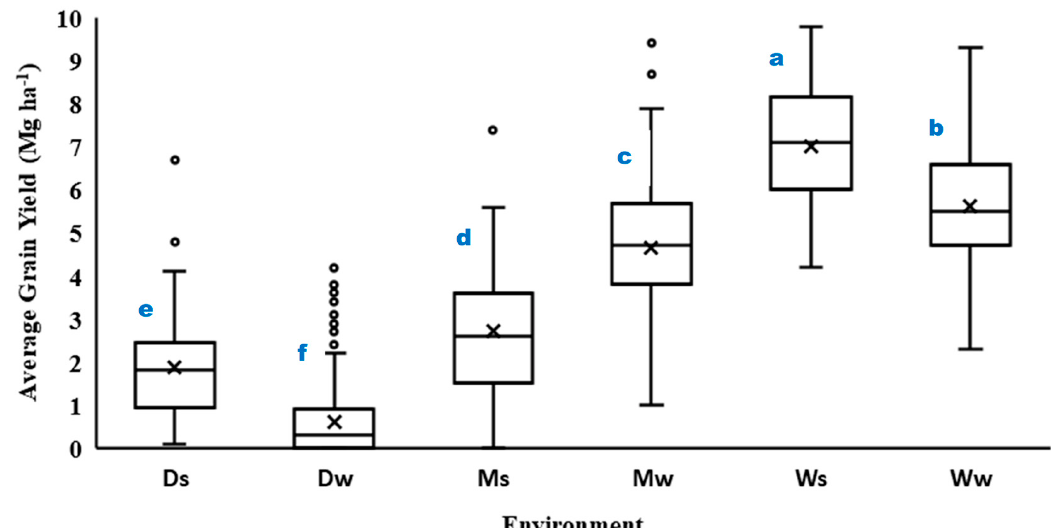
Figure 1. Overall average maize grain yield per environment in southern Mozambique. Ds = Poorly watered in summer; Dw = Poorly watered in winter; Ms = Moderately watered in summer; Mw = Moderately watered in winter; Ws = Well- watered in summer; Ww = Well-watered in winter. Different letters indicate significant differences at 0.1% probability level.